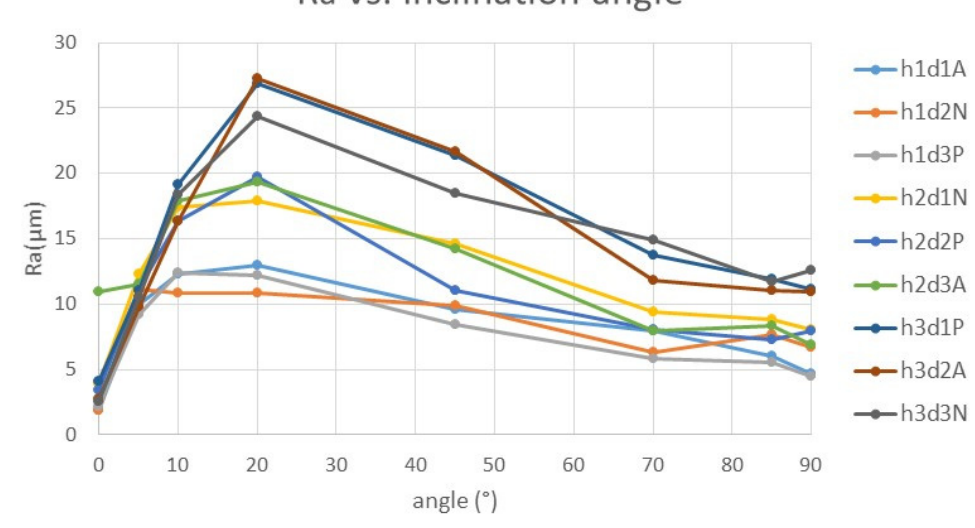
Figure 6. Average Ra values according to the angle of each surface measured.